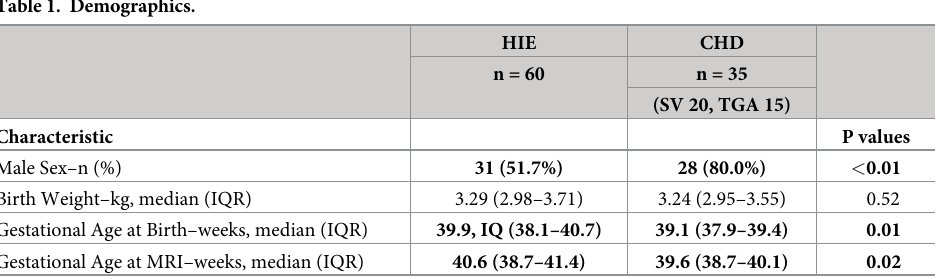
Table 1. Demographics.